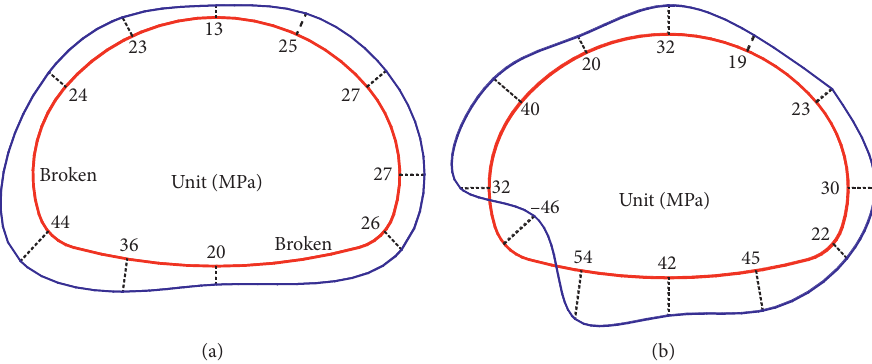
Figure 17: Steel stress distribution of secondary lining in YK2+ 133 section. (a) Maximum stress value of outside stress. (b) Stability value of inside